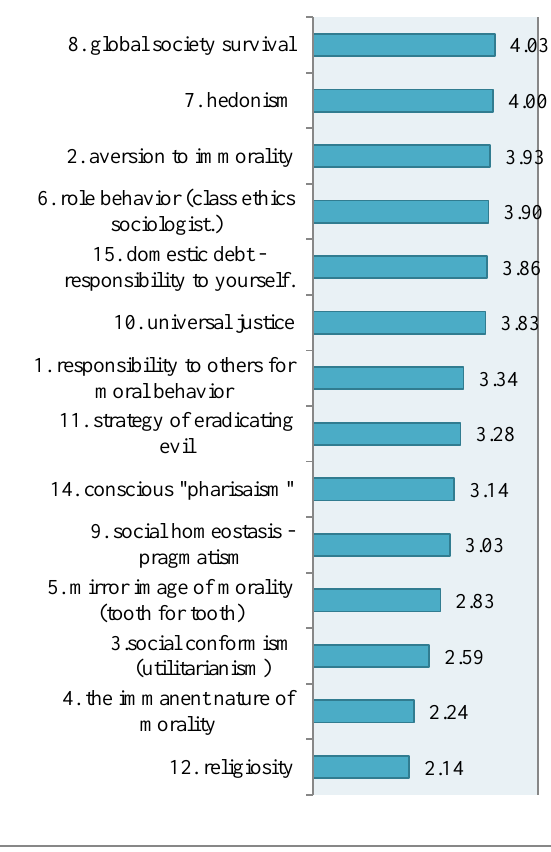
Fig. 9. Results according to the methodology of moral value